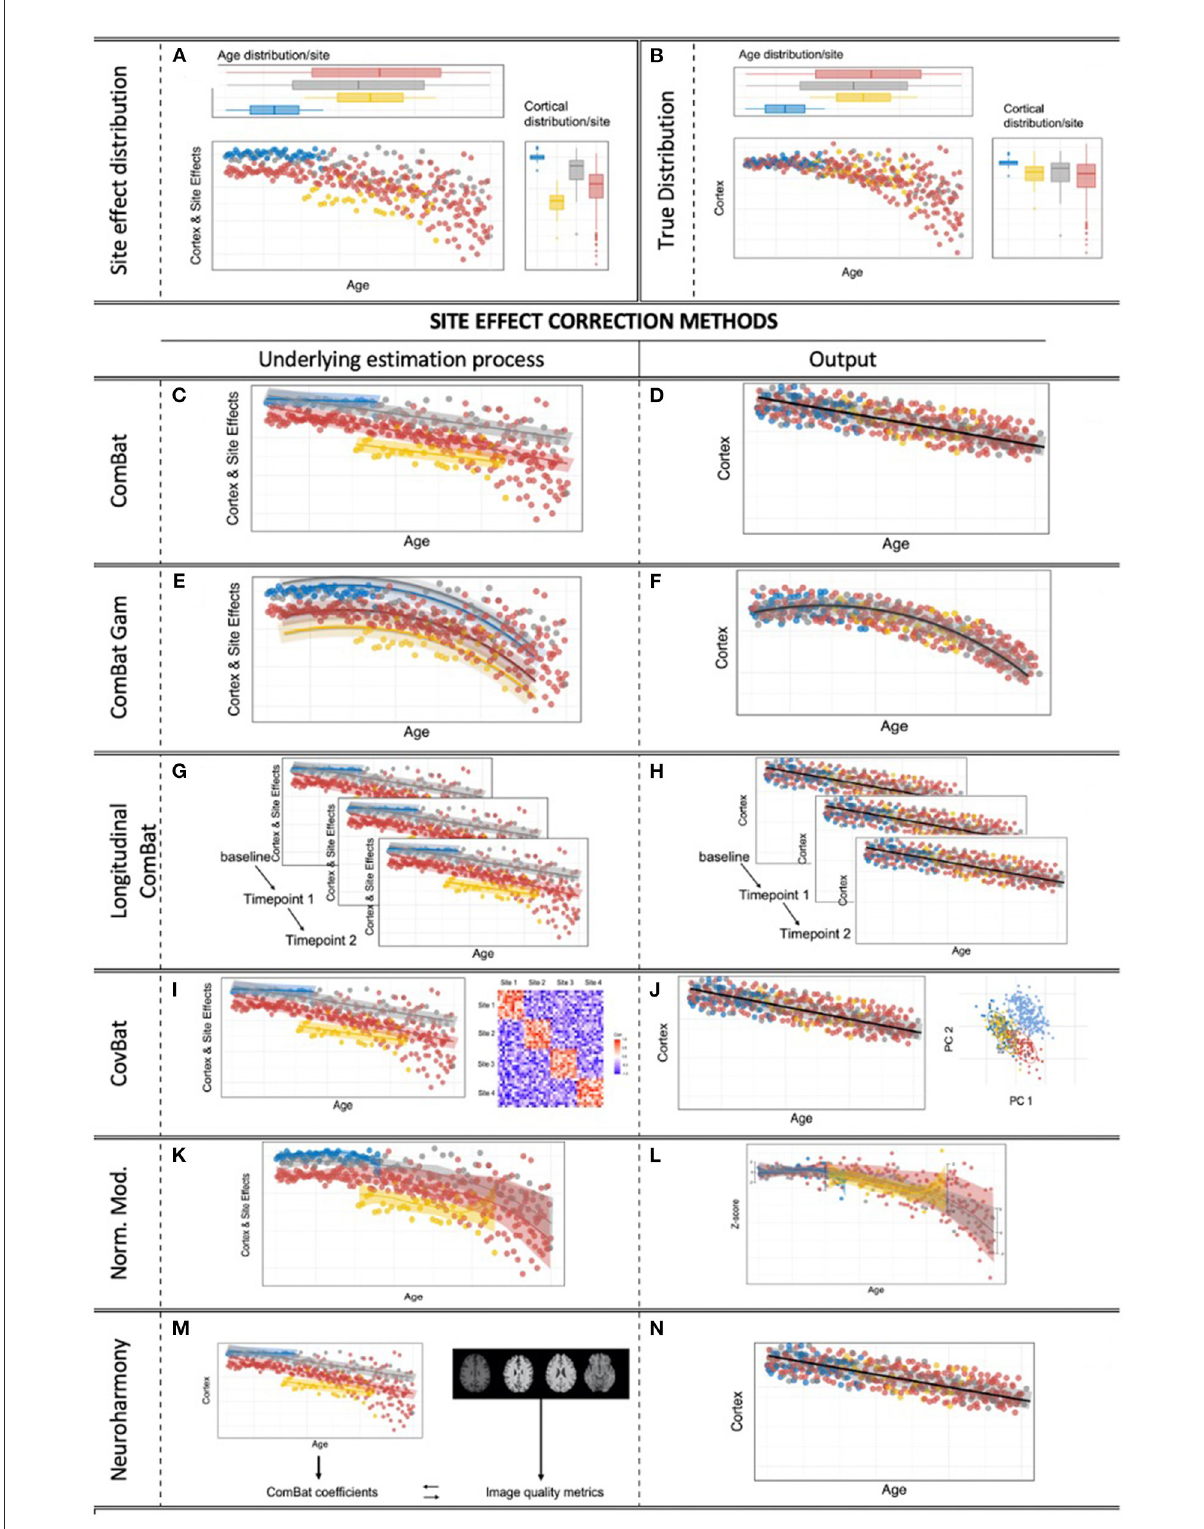
FIGURE2 Site effects & correction methods for multi-site effects in neuroimaging. (A) Obvious site effects with preserved age effect within the sites. (B) True, underlying, unknown heteroscedastic distribution. (C,D) The standard ComBat algorithm provides linear adjustment of site